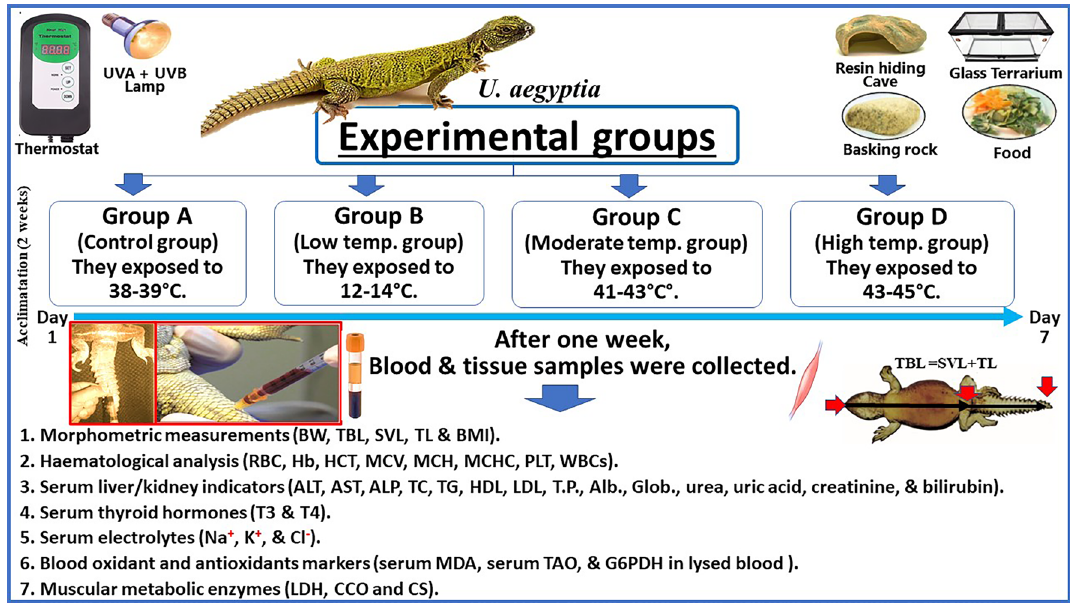
Figure 1. It represented experimental design and measuring